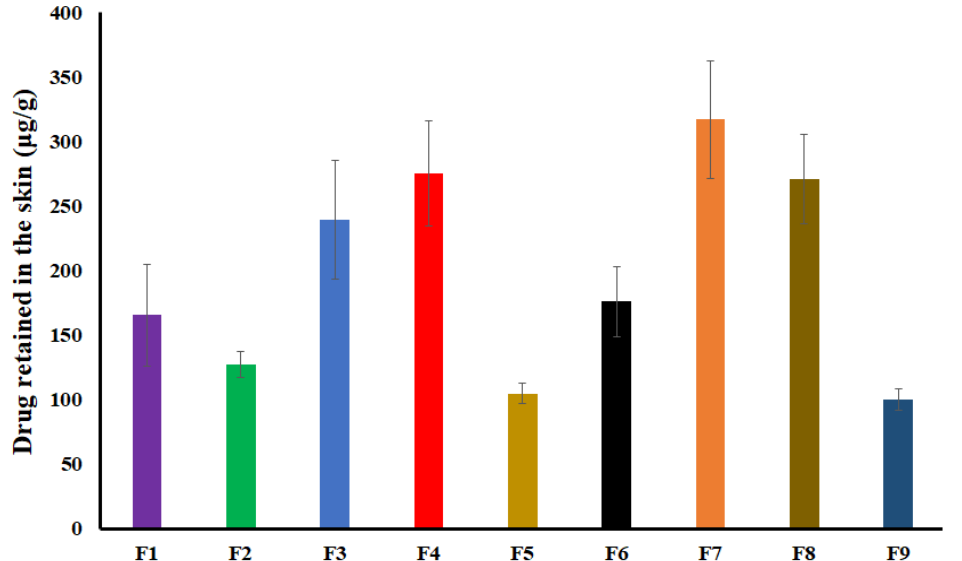
Figure 7. Drug retained in pig ear skin after the permeation experiment. Data are shown as mean ± SD, n =